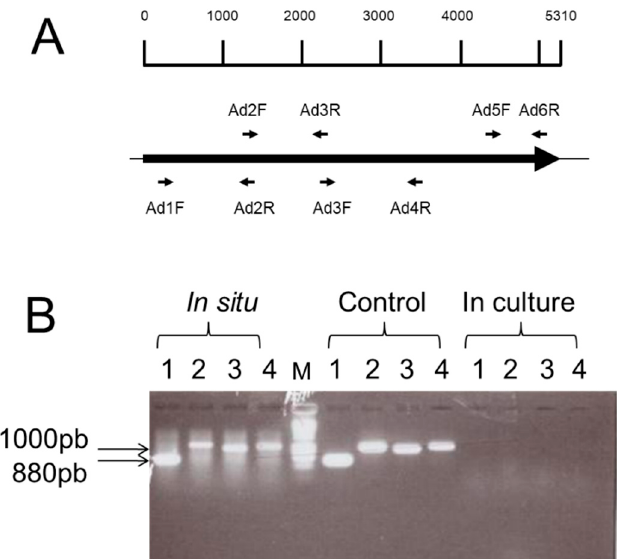
Figure 2. Schematic localization of the PCR-primers along the radA gene ( A ) and expression of radA ( B ). In situ : RT-PCR on total RNA extracted from E1-mono-contaminated rats. In culture: RT-PCR on total RNA extracted from E1 culture in BHI-YH medium. Control: PCR on E1 chromosome DNA. Lines 1, 2, 3 and 4 correspond to PCR reactions carried out with couples of primers Ad5F-Ad6R, Ad3F-Ad4R, Ad2F-Ad3R and Ad1F-Ad2R, respectively. M stands for the GeneRuler 1kb DNA Ladder marker. 1000 bp and 800 bp with arrows point to the size of the products.